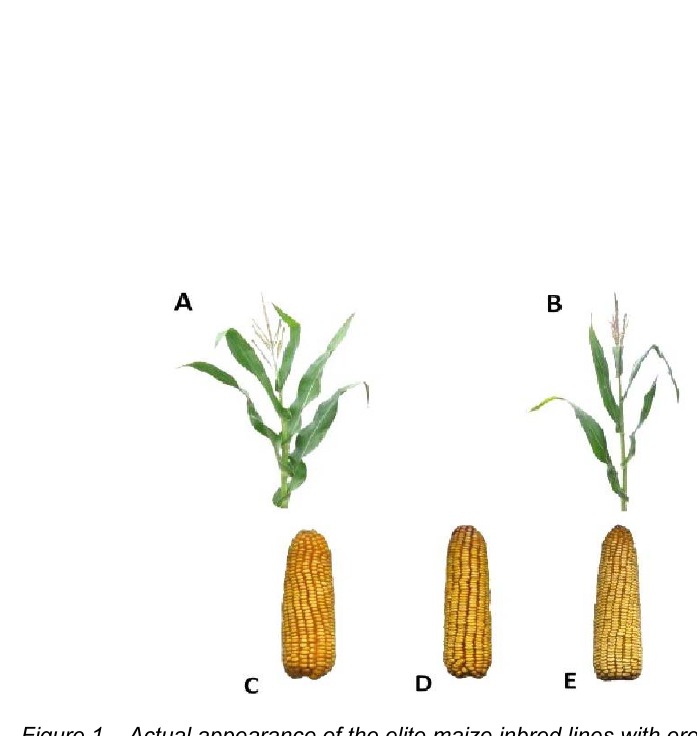
Figure 1 – Actual appearance of the elite maize inbred lines with erect top leaves ZPPL 146 (A) and ZPPL 159 (B) and the high-quality maize hybrids ZP 633 (C), ZP 735 (D) and ZP 737 (E) with their erect top